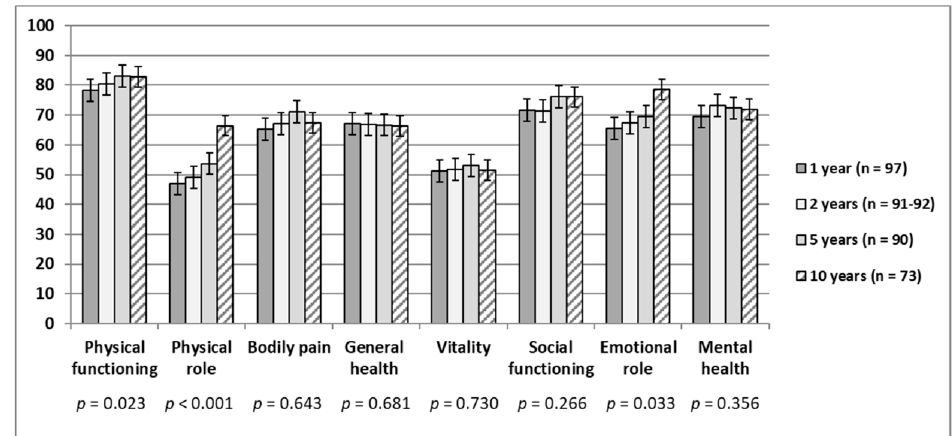
Figure 1. Medical Outcomes 36-Item Short Form Health Survey (SF-36) mean subscale score changes for the study population across 10 years after moderate to severe TBI. The error bars display the standard error of the mean subscale score at each time point. The p -values from paired samples t -tests investigating the change in mean scores from 1- to 10-year follow-up are shown below each subscale.